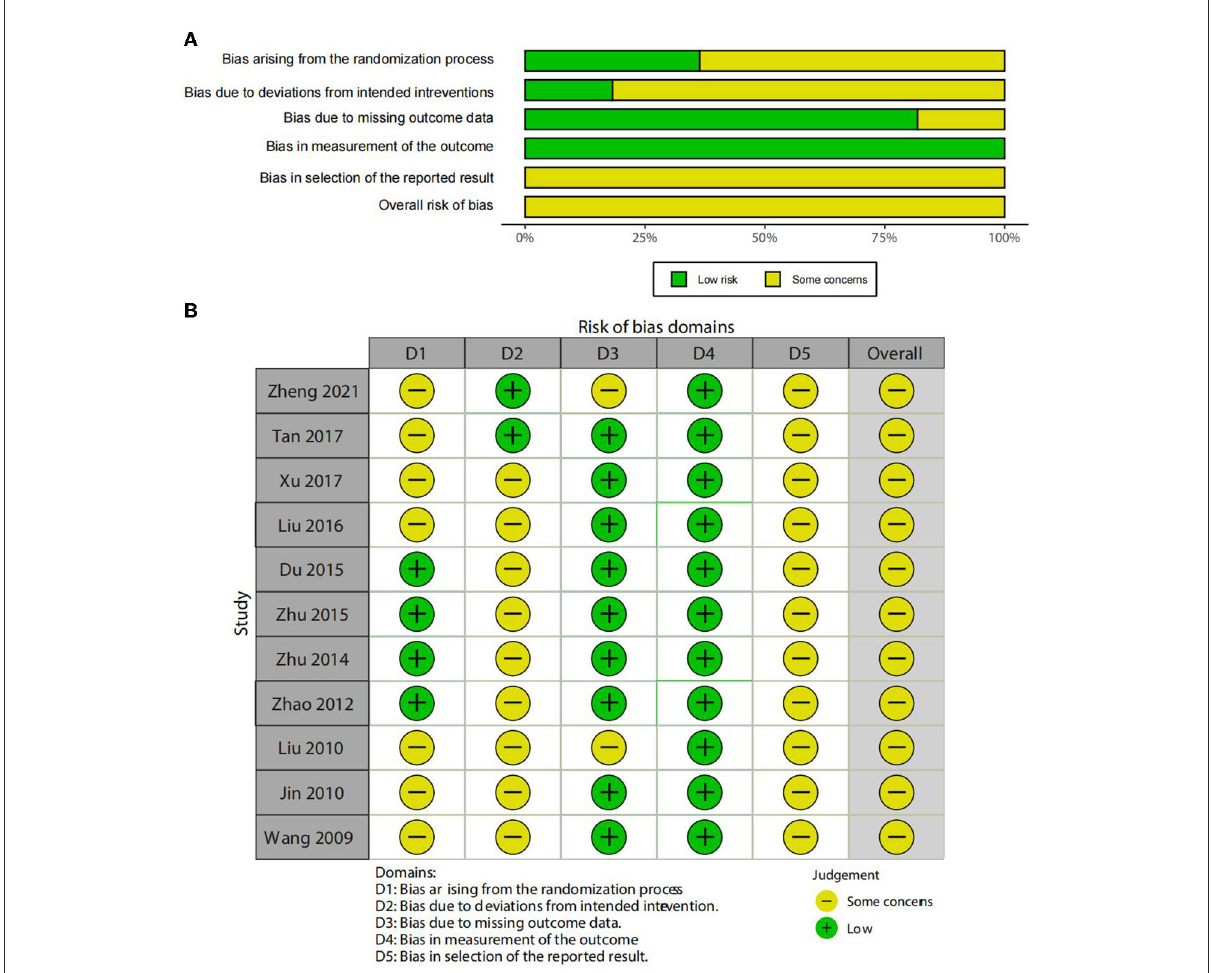
FIGURE2 (A) Risk of bias graph and (B) Risk of bias